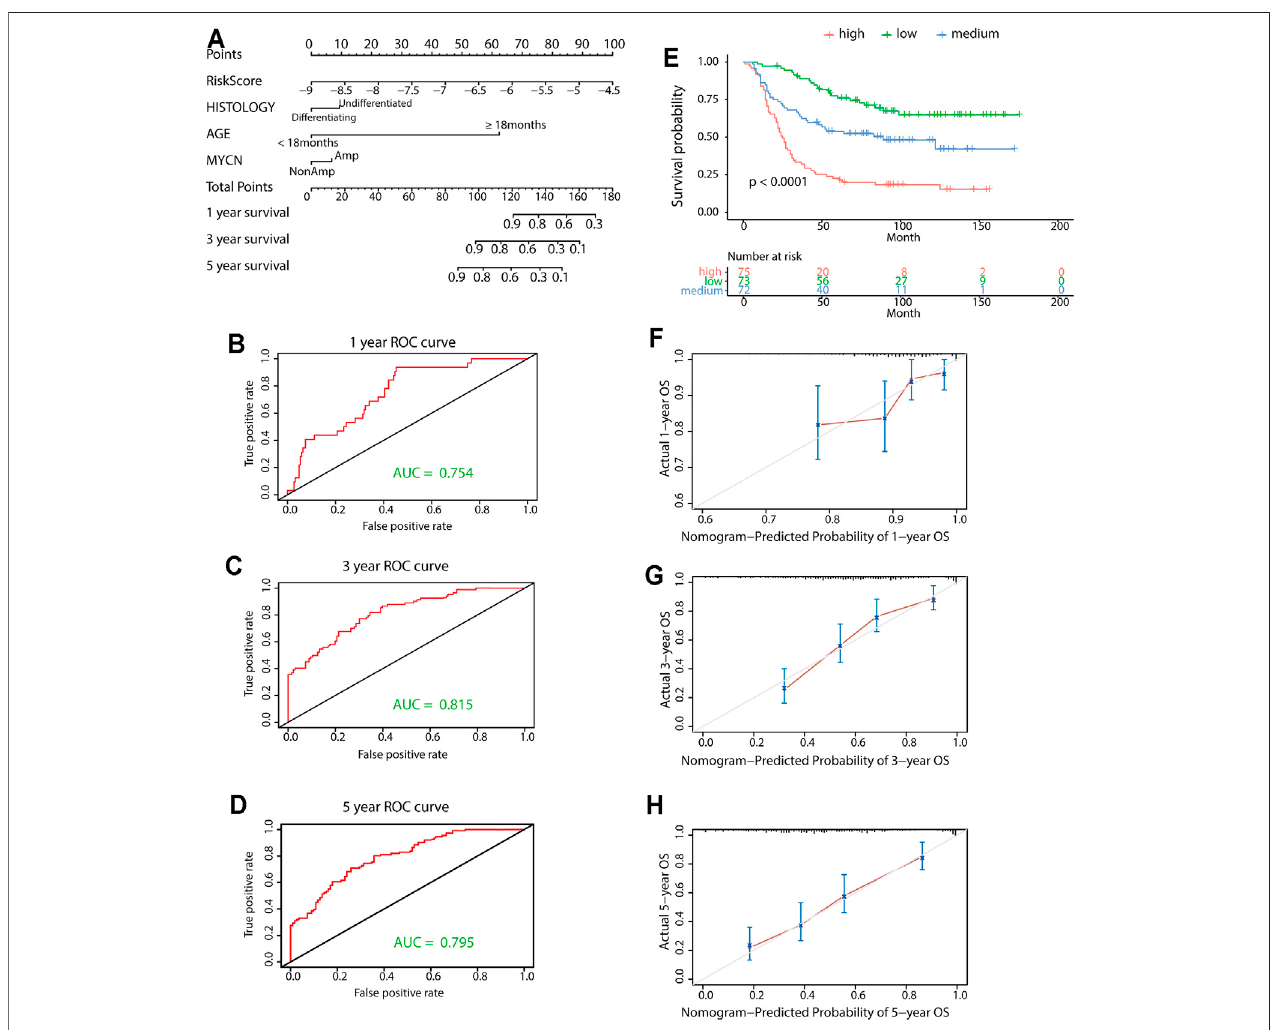
FIGURE 8 | Construction and validation of the nomogram model. (A) Nomogram model for 1-year, 3-year, and 5-year overall survival probability predictions in the TARGET data set. (B-D) Time-dependent ROC curves for survival predictions for the nomogram. (E) KM survival curves of the nomogram. Patients from the TARGET datasetwereclassi fi edintothreegroupsbasedonthetertilepointcalculatedbythenomogrammodel. (F-H) Calibrationplotforinternalvalidationofthenomogram.The Y -axis represents the actual overall survival, while the X -axis represents the predicted overall